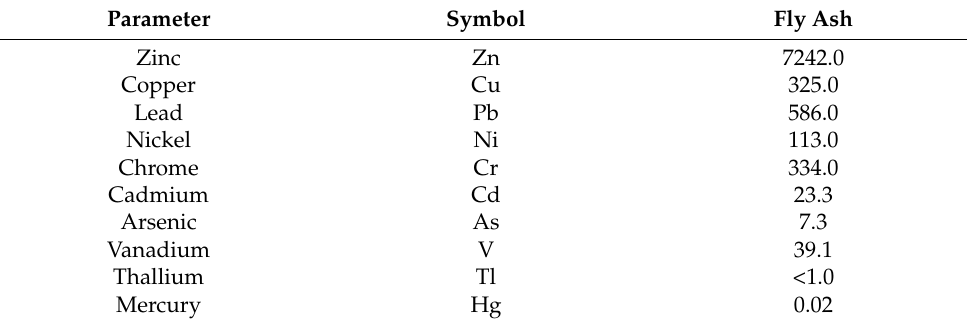
Table 2. Heavy metal concentrations, expressed in